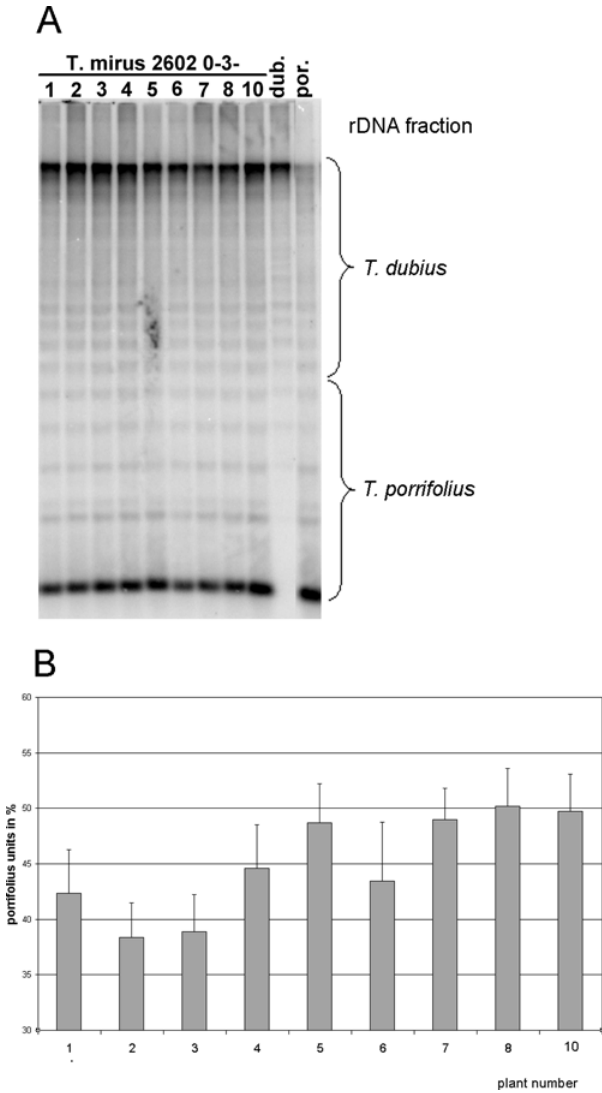
Figure 6. Genomic analysis of 5S rDNA repeats. (A) Southern blot hybridisation of 5S rDNA probe to Taq I-digested genomic DNA of the progeny of 2602-0-3 individual and diploid parental accessions. (B) Quantitative representation of the parental 5S gene families deter- mined by a phosphorimager scanning of radioactivity signals on blots (three independent experiments).